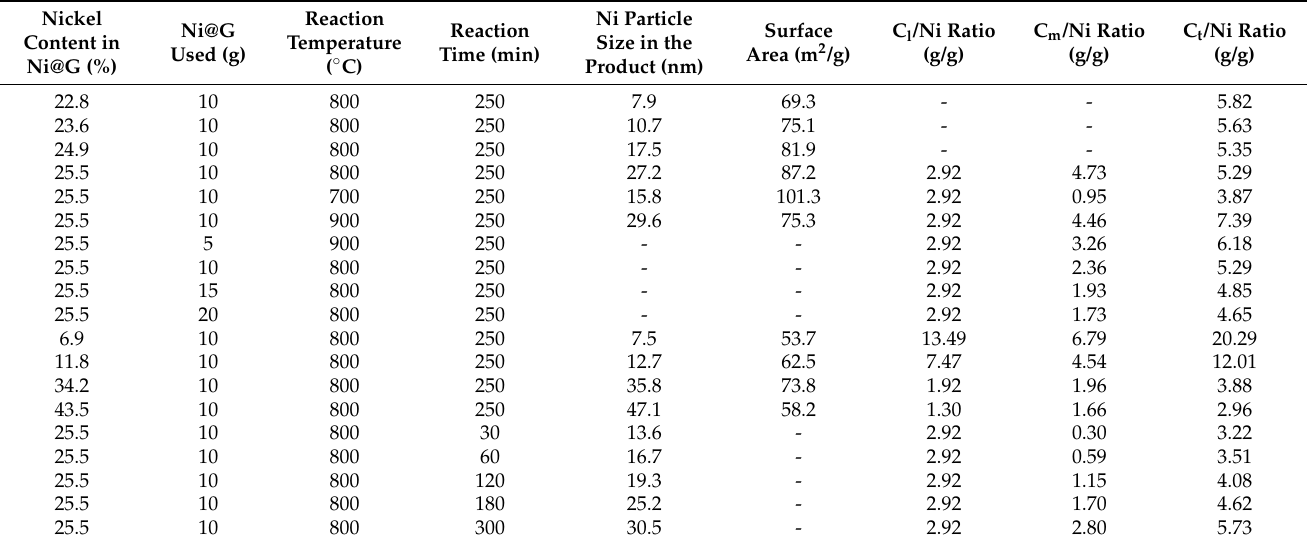
Table 2. Graphene-based materials from CDM reaction over graphene-encapsulated nickel nanopar- ticles (Ni@G). The “@G” indicates the graphene